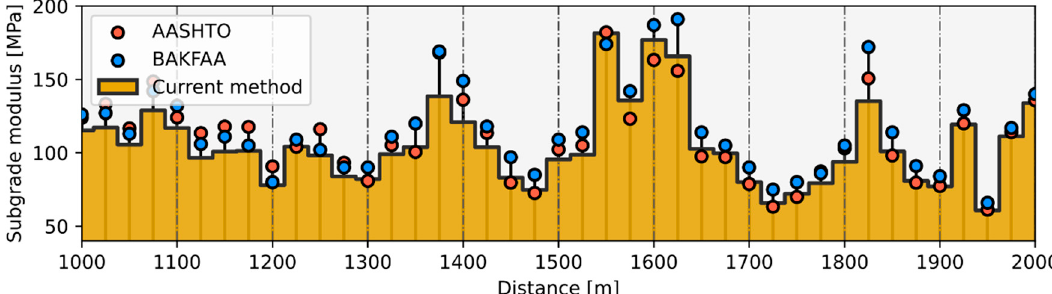
Figure 20. Comparison between current method results and AASHTO and BAKFAA approaches.